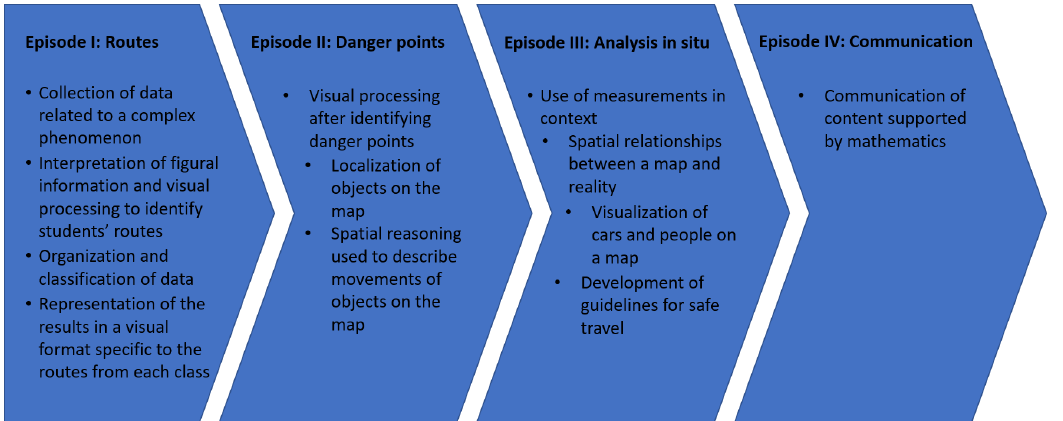
Figure 6. Mathematical learning opportunities identified during the project.